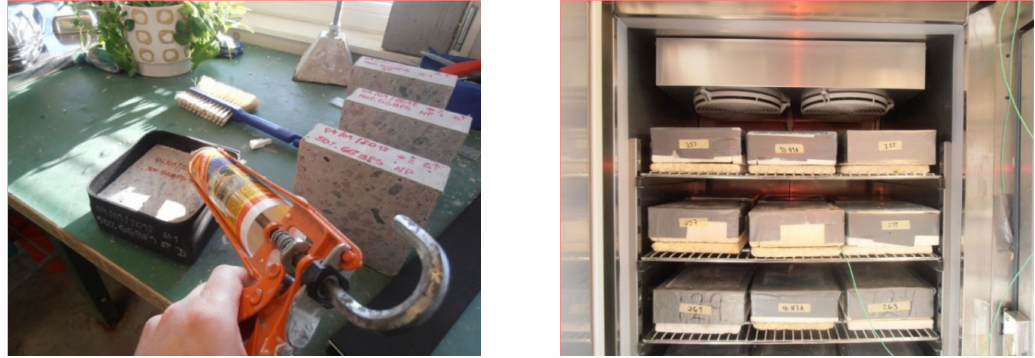
Figure 7. Preparation of salt-frost scaling tests. Left : Application of the rubber cloth and silicone sealant on the test specimens; Right : Salt-frost scaling test specimens placed in the climate